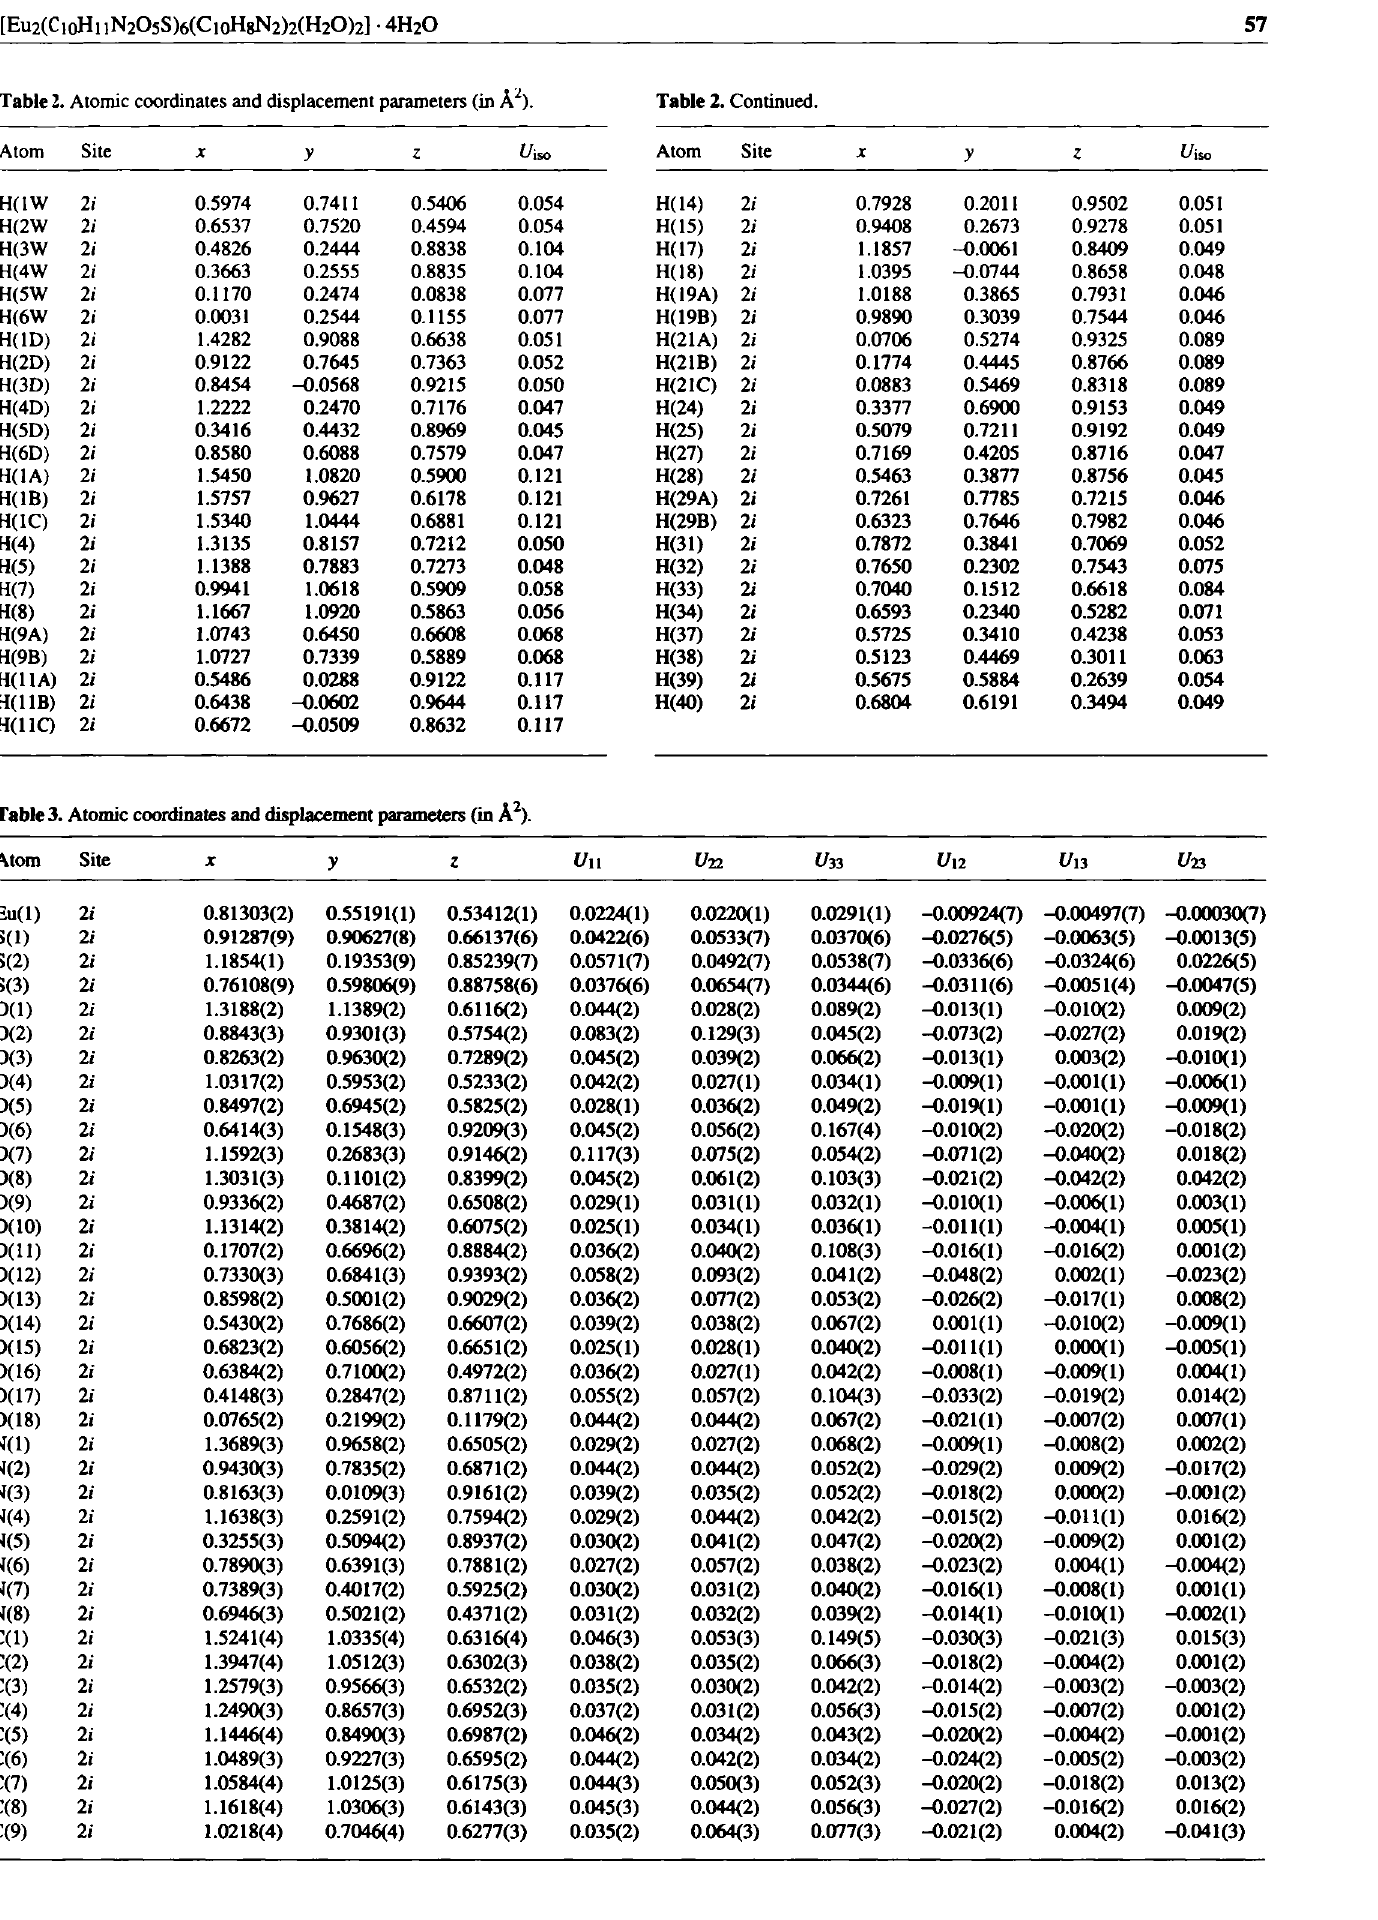
Table 2. Atomic coordinates and displacement parameters (in À·*). Table 2. Continued.